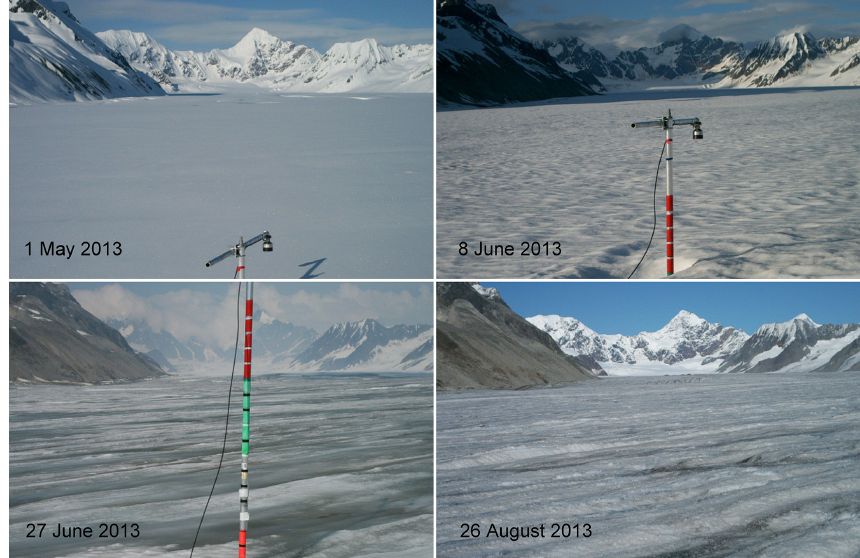
Figure 15. Photos from the time-lapse camera on West Fork Glacier show surface conditions: smooth fresh snow (1 May 2013), aged snow with rougher surface (8 June 2013), recently exposed bare ice with some water-saturated snow (27 June 2013), aged ice surface (26 August 2013).